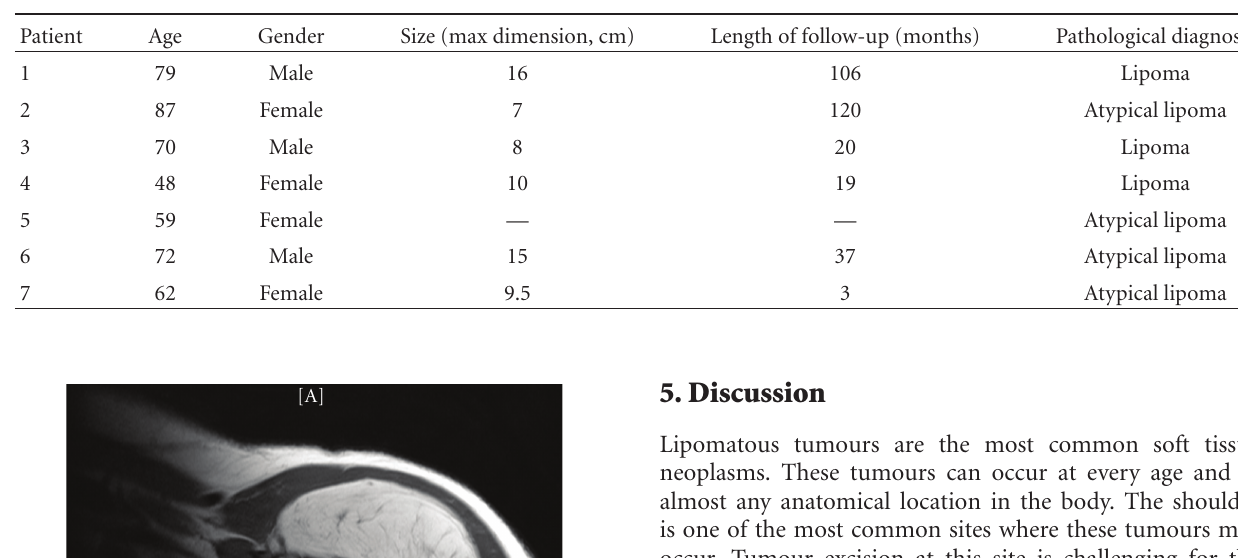
Table 1: Patient and tumour characteristics.